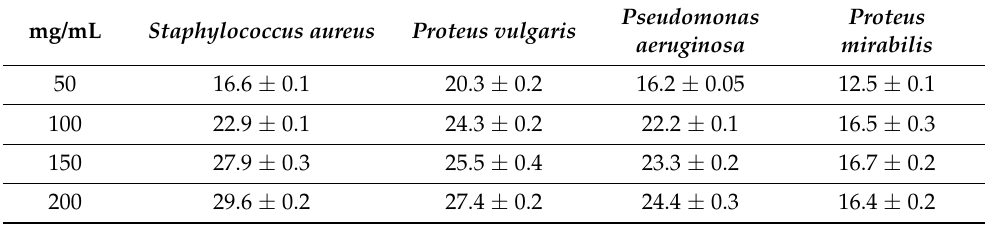
Table 3. Antibacterial activity of EEPO. Results are recorded as mean ± standard